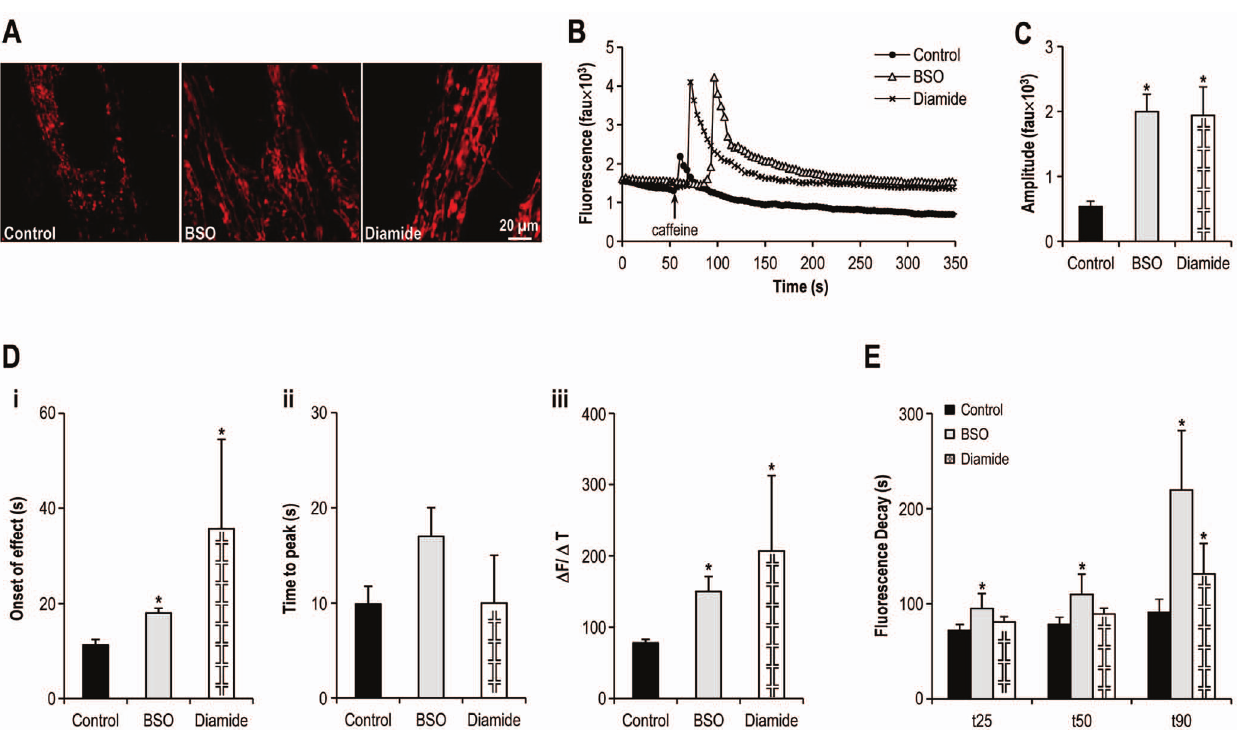
Figure 7. Oxidative stress promotes mitochondrial fusion and results in altered SR calcium handling. Panel A: Confocal microscopy images of differentiated C2C12 myotubes having been previously treated with BSO or diamide, and loaded with TMRE. Panel B: Representative tracings of the fluorescence profile of myotubes cultured under oxidative stress and loaded with fluo-4 prior to the application of caffeine to trigger SR calcium release (BSO, Diamide v control). Panel C: Objective mean quantitative data for fluorescence resulting from caffeine induced calcium release (BSO, diamide v. control). Panel D: Objective mean quantitative data for fluorescence kinetics profile resulting from caffeine induced calcium release (BSO, diamide v. control). Panel E: Histogram displaying the mean quantitative data relating to the normalization of fluorescence following caffeine application (BSO, diamide v. control). * Denotes p , 0.05 – 0.001 ANOVA, n=40 per group.